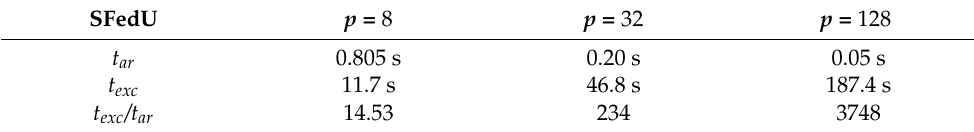
Table 3. Time spent transitions to new integer time slices for the SFedU multiprocessor system. SFedU p = 8 p = 32 p = 128 t ar 0.805